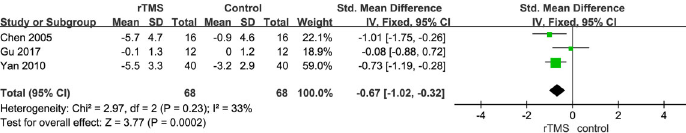
Figure 3. Comparison of repetitive transcranial magnetic stimulation (rTMS) and control conditions for stroke recovery in post- stroke depression patients based on change in scores in related rating scales. See Table 1 for corresponding numbers of references.